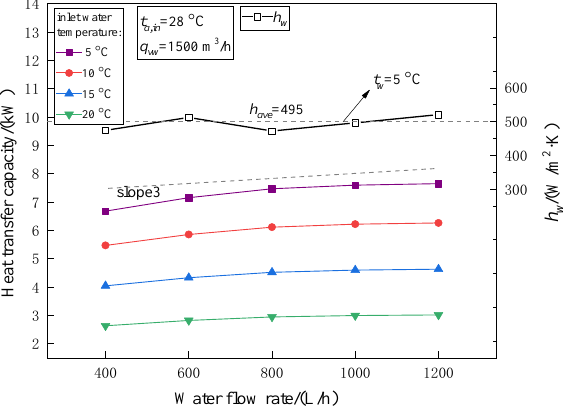
Figure 13. Variation of heat transfer rate and h w .